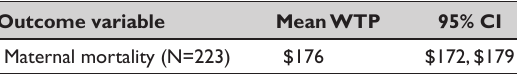
Table 3: Estimated Mean WTP for Reducing Maternal Mortality Risk